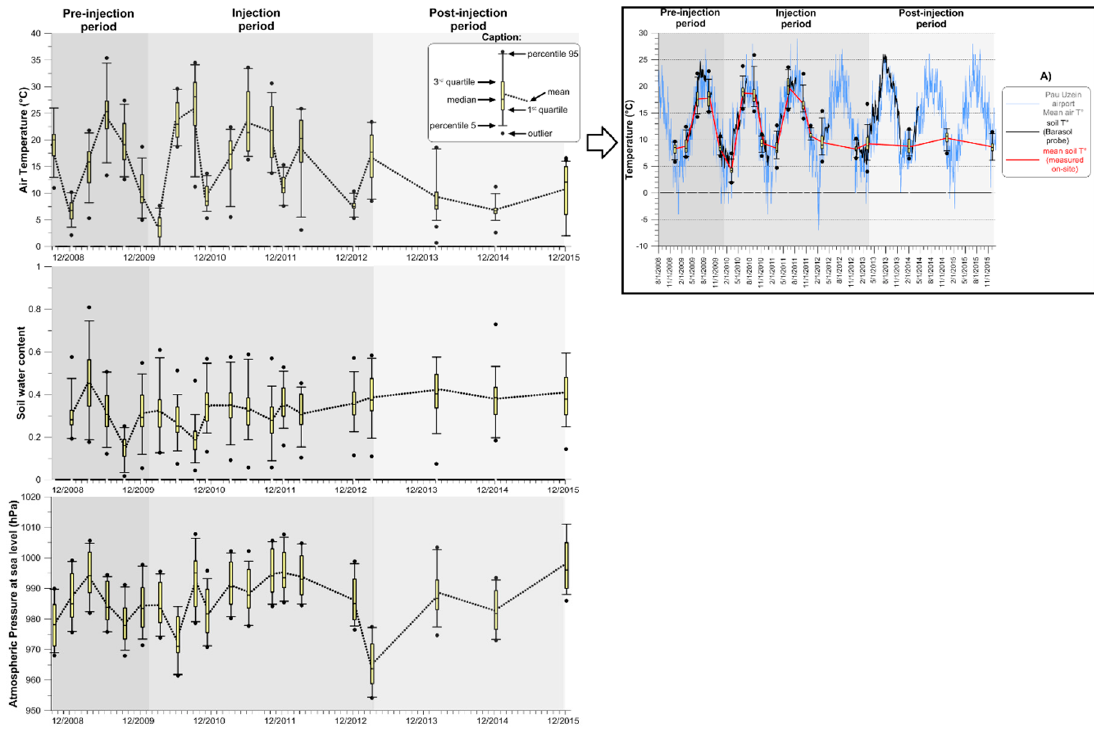
Figure 2. Air temperature, soil water content and atmospheric pressure measured during each field session at each monitoring location. Data are shown as box plots presenting median value, quartiles and outliers. The inset on the right details the evolution of soil temperature measured at each point and measured at Point 24 using a Barasol probe (in black), and the mean air temperature measured at Pau-Uzein airport (in blue;